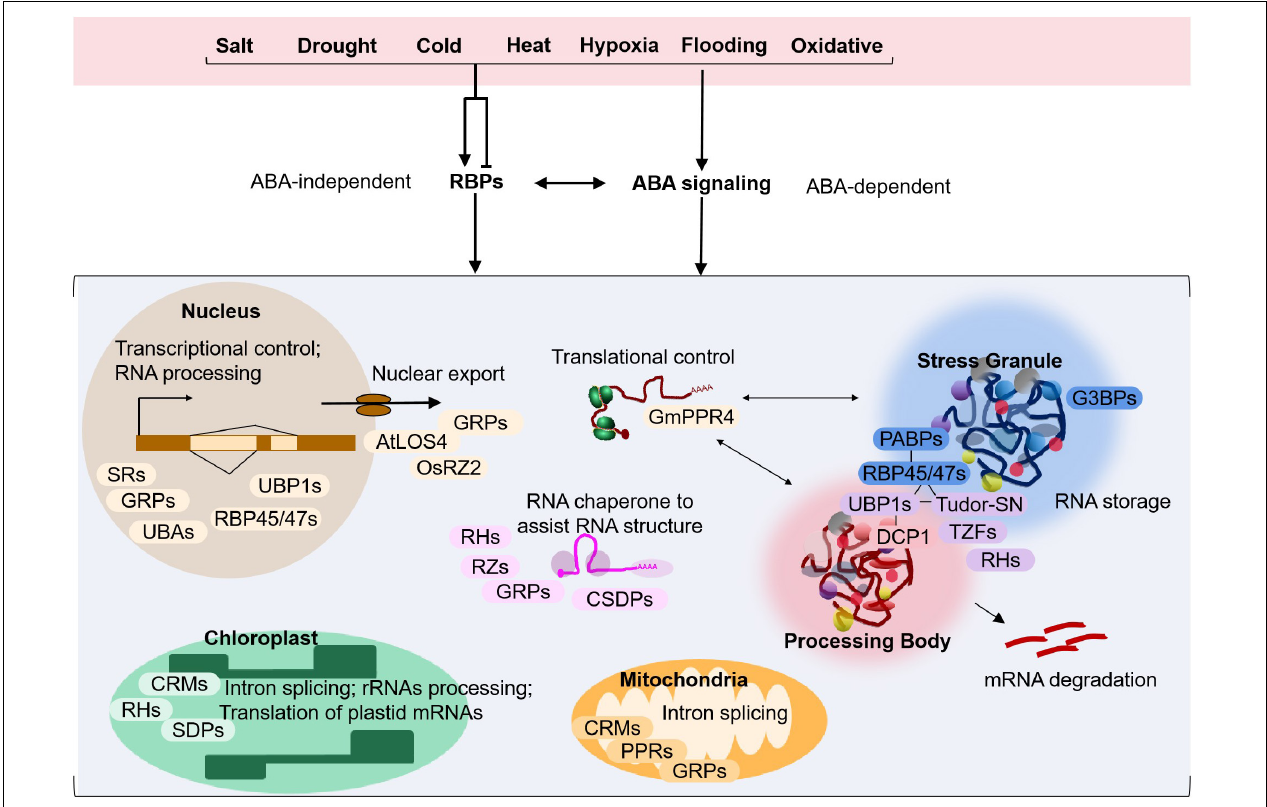
FIGURE 1 | Model depicting the regulatory functions of the typical RNA-binding proteins in plant adaptation to abiotic stress. Environmental stress caused by salt, drought, cold, heat, hypoxia, flooding or oxidative conditions may induce or repress the expression of relevant RBPs. During the response, RBPs may act in a ABA-dependent or independent pathway to regulate gene expression and play various roles in RNA metabolism including RNA processing and alternative splicing in the nucleus, nuclear export of mRNAs, mRNA degradation via processing bodies, mRNA storage in stress granules, and translational control in the cytoplasm. Some RBPs may also function as RNA chaperones to assist RNA folding and structure remodeling. Nuclear-encoded RBPs may also be targeted to chloroplasts or mitochondria and participate in intron splicing, rRNAs processing and/or translation of plastid mRNAs, processes critical for organellar biogenesis and function during plant adaptation to stress. Examples of RBPs that are involved in each cellular process are shown in the model. More detailed information can be found in Table 1 and in the main